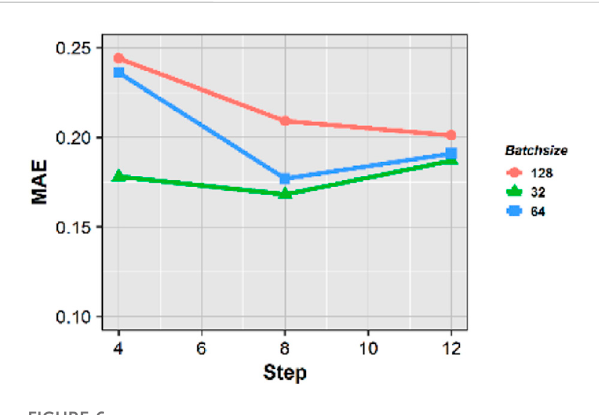
FIGURE 6 MAE value with different steps and batch